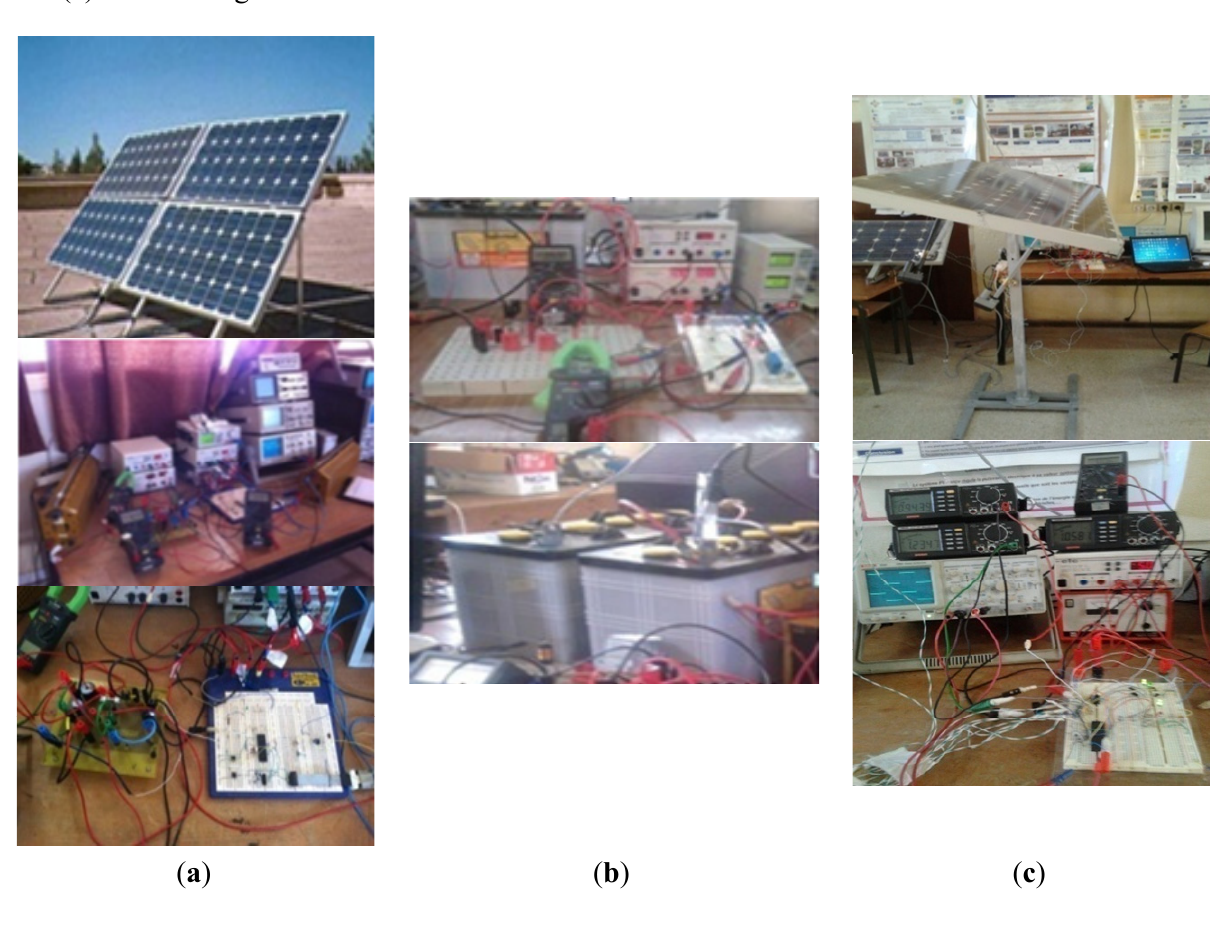
Figure 13. Experimental procedure, ( a ) MPPT control; ( b ) charges/discharge; ( c ) sun